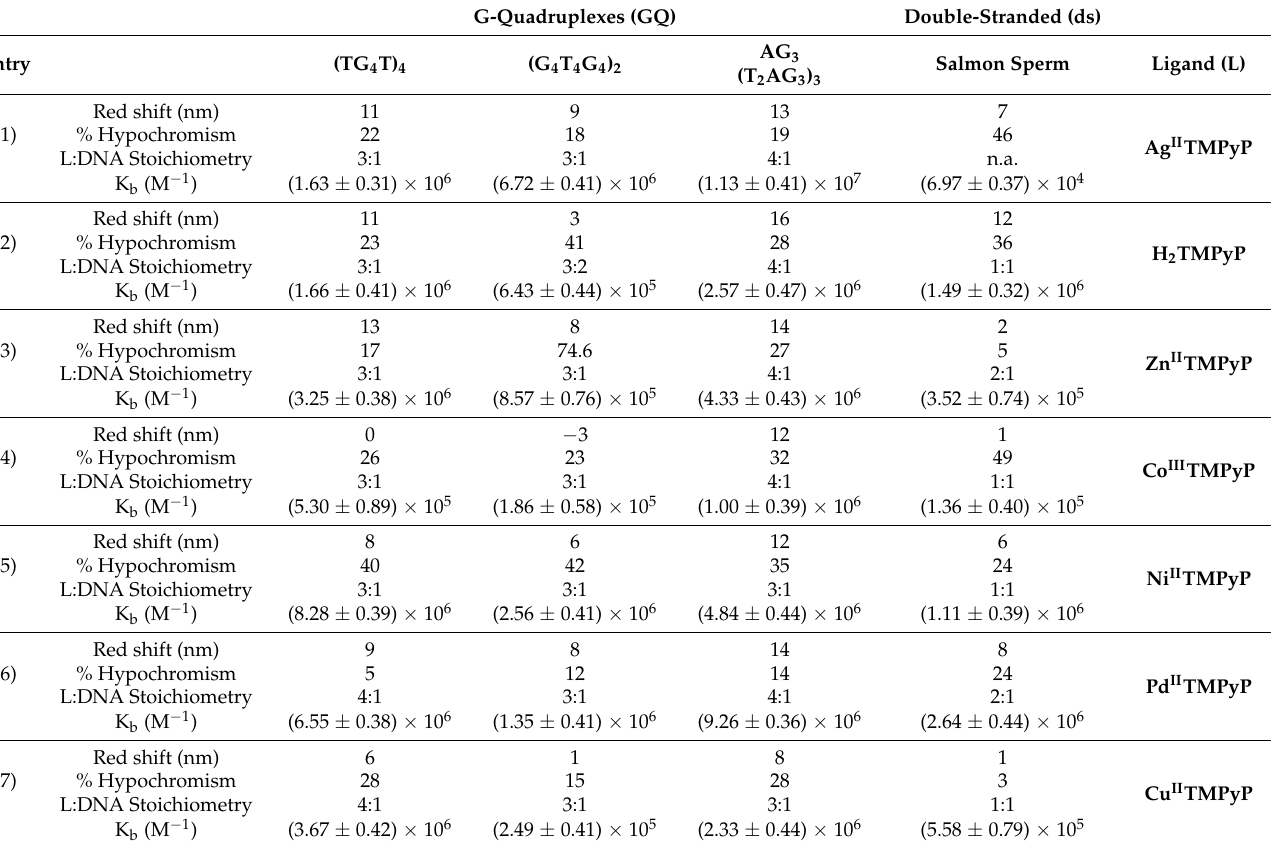
Table 3. Red shift, % hypochromism and Kb values obtained for H 2 TMPyP and its metal complexes. G-Quadruplexes